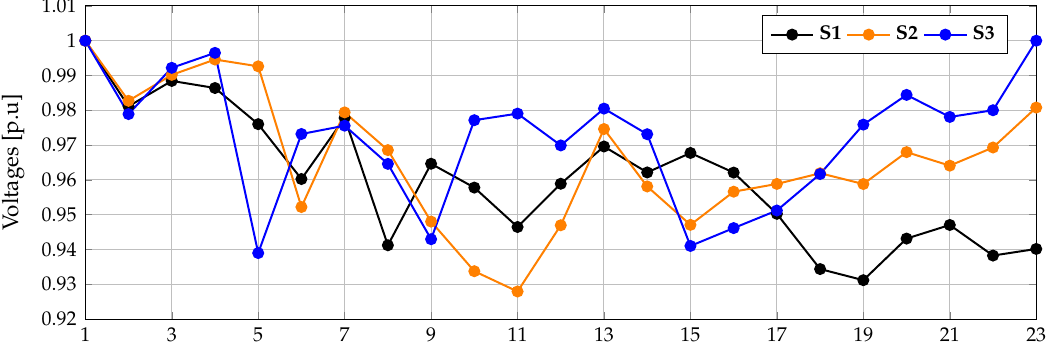
Figure 8. Voltage comparison between initial and final configurations in the 10-nodes test